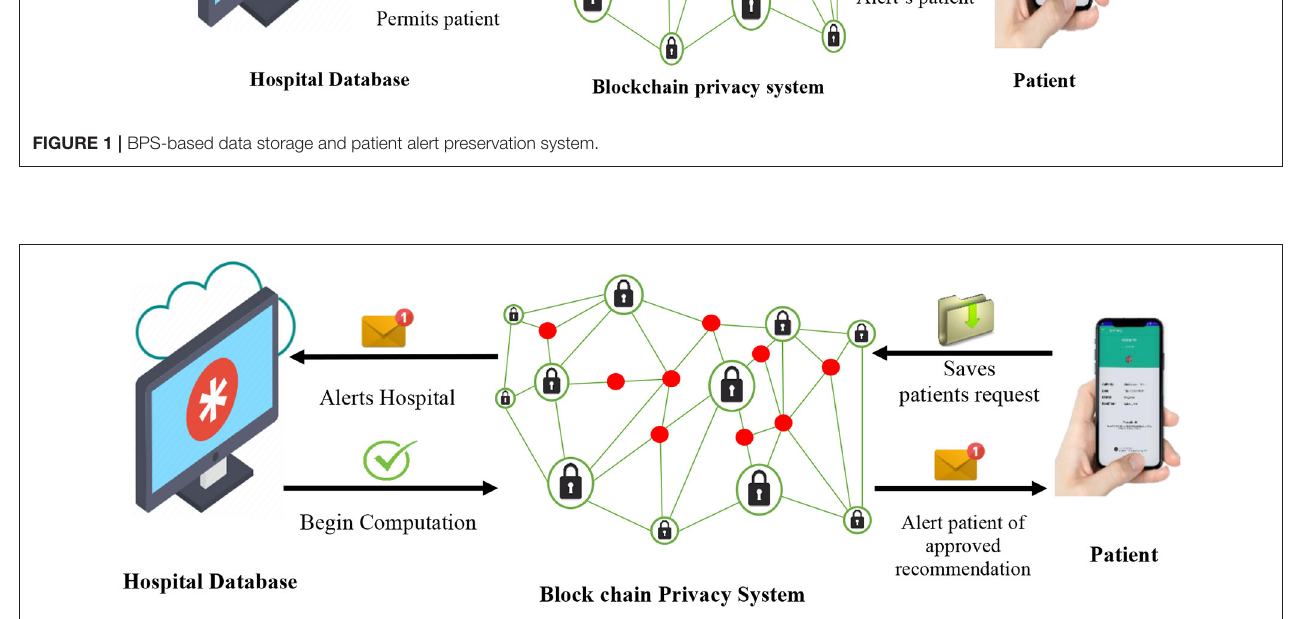
FIGURE 2 | BPS-based data storage, hospital management and preservation